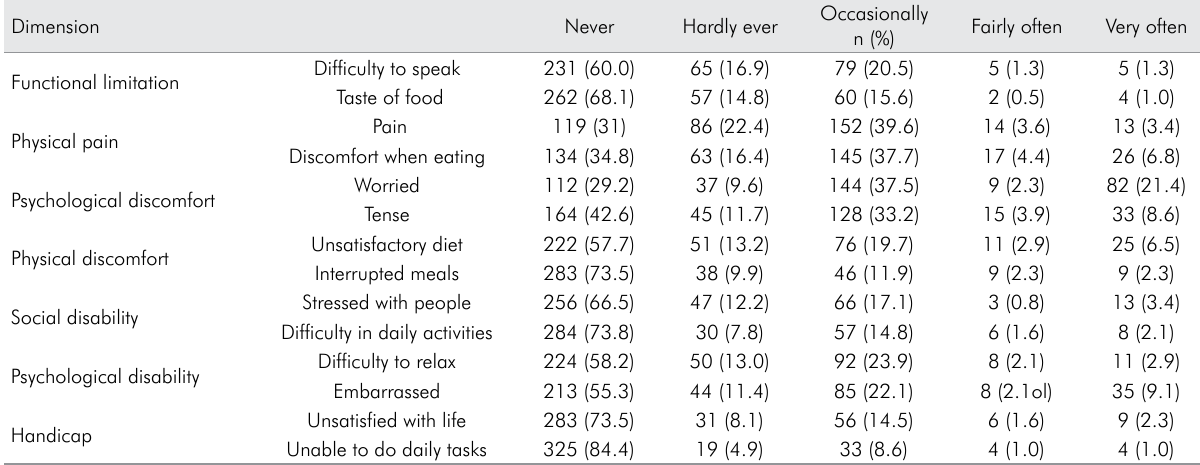
Table 2. OHIP 14 Oral Health Impact Profile of workers.